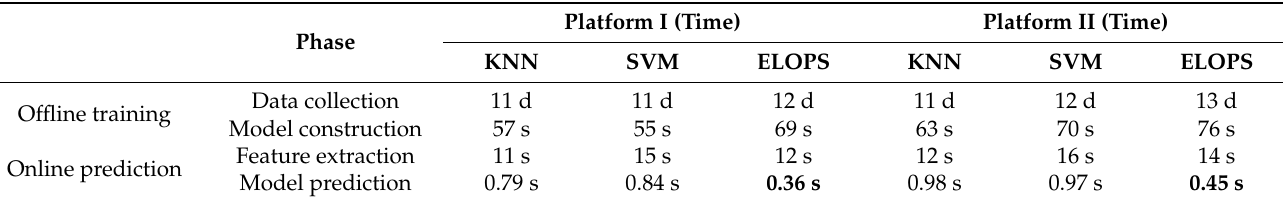
Table 8. Prediction time on the different